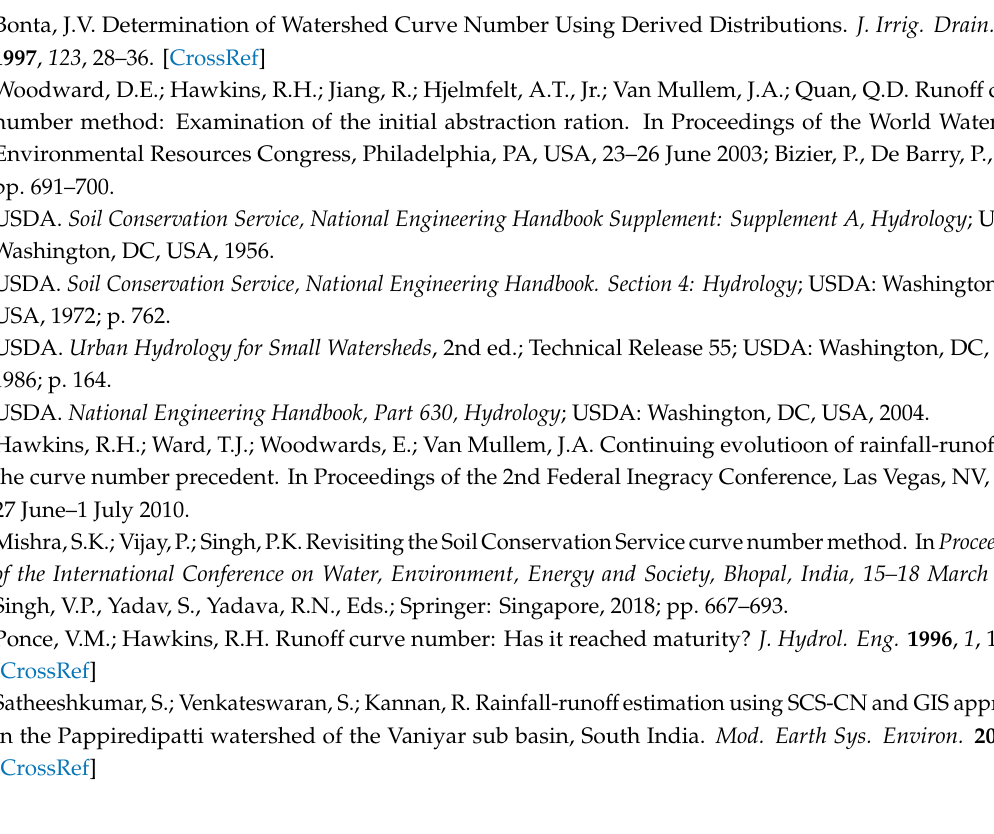
Figure S1a: Comparison of observed direct runo ff heights (mm) with those simulated in the experimental catchments using discrete mean and median λ values with AMC classified (AMC all), Figure S1b: Comparison of observed direct runo ff heights (mm) with those simulated in the experimental catchments using discrete mean and median λ values with AMC implicitly set as normal (AMC = II), Figure S2: Comparison of observed direct runo ff heights (mm) with those simulated in the experimental catchments using regressions of λ according to P for events with AMC classified (AMC all) and implicitly set as normal (AMC =